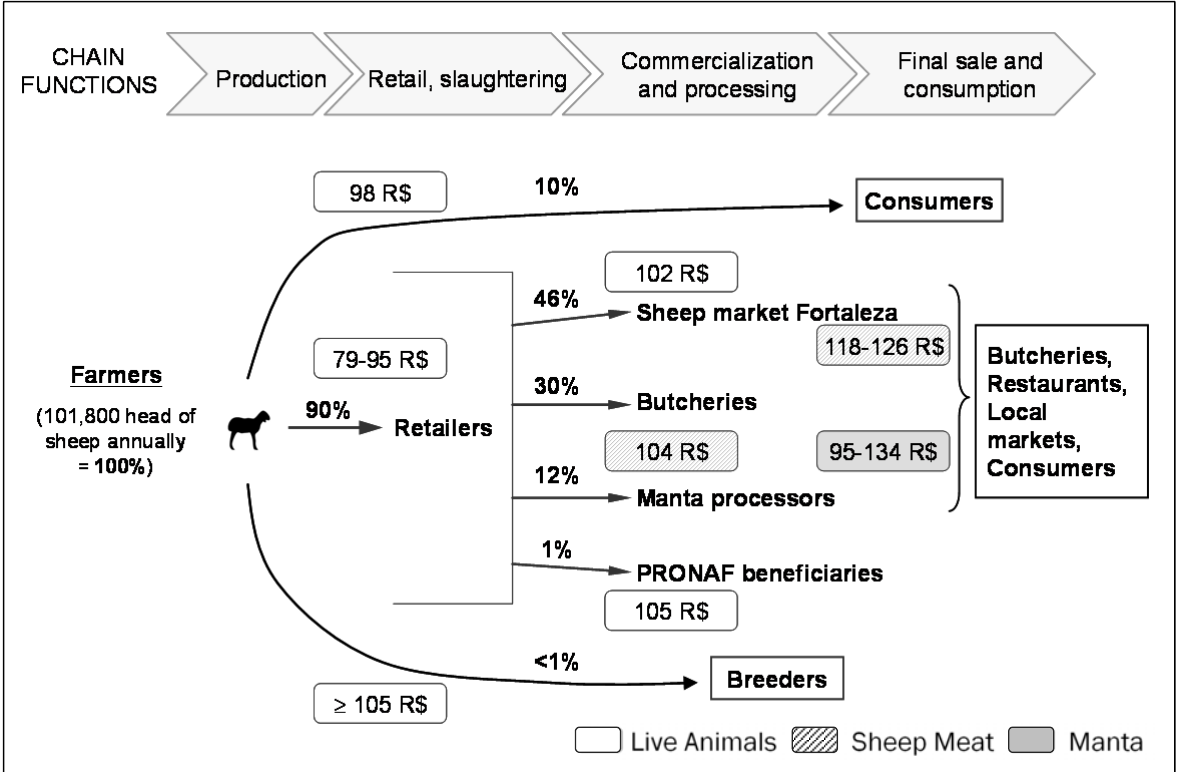
Figure 4. Estimated Relative Trade Volumes of Sheep, and the Respective Sale Prices of Live Animals, Sheep Meat, and Manta, Corrected to One